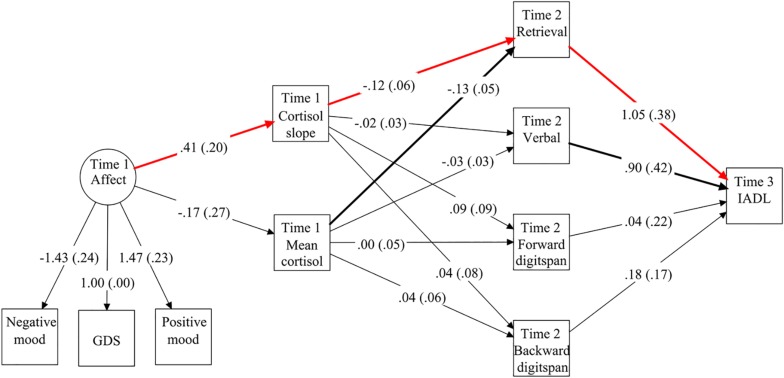
Unstandardized path coefficients in the structural equation model, with significant paths among the main study variables highlighted in bold. The red paths denote the indirect effect from negative affect to IADL via diurnal cortisol slope and memory retrieval. Standard errors are shown in parentheses. To simplify the presentation, the figure does not include the demographic and baseline control variables or the residual covariances among the dependent variables.